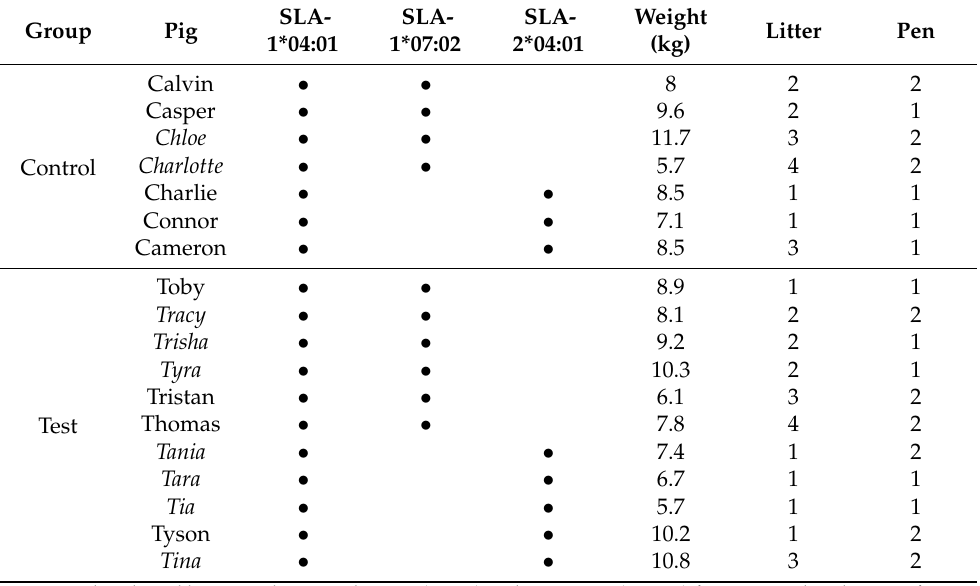
Table 1. Background of the 18 pigs included in the vaccine-challenge